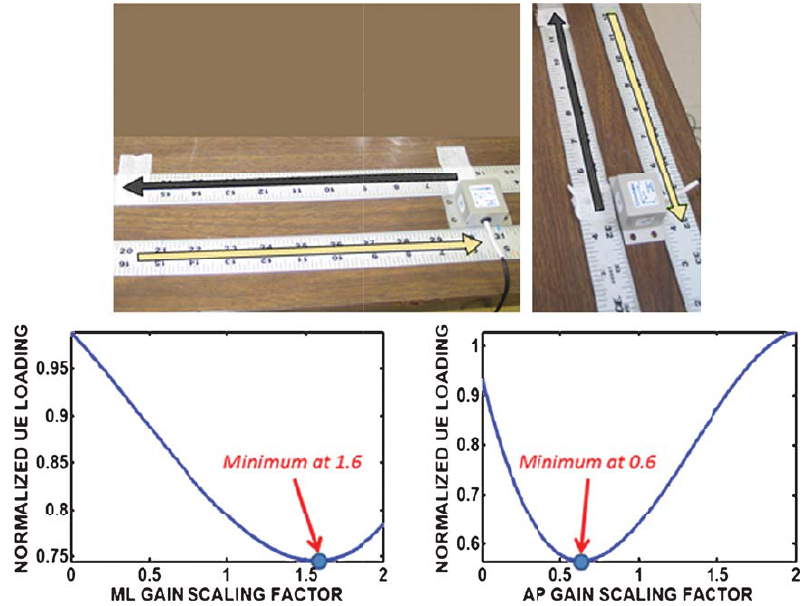
Fig. 2. TOP: Subject manually slide-shifts (dark/light arrow is initial away/return direction) an accelerometer along either the medial-lateral (ML, pictured left) or anterior-posterior (AP, pictured right) dimension. BOTTOM: Third-order polynomial fits for normalized upper extremity (UE) loading versus gain from [12,